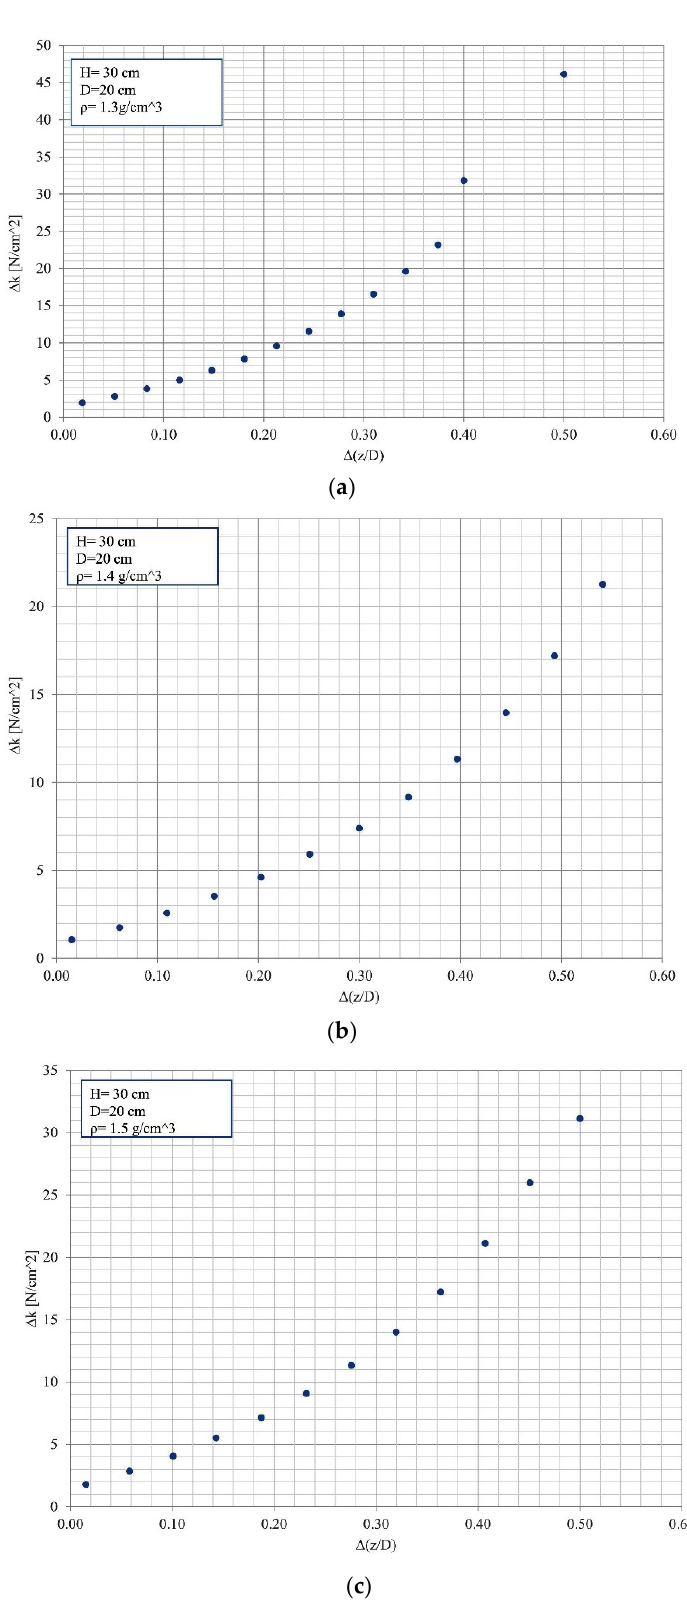
Figure 10. The relationship of ∆k and ∆(z/D) for a soil thickness level of 30 cm at bulk densities of